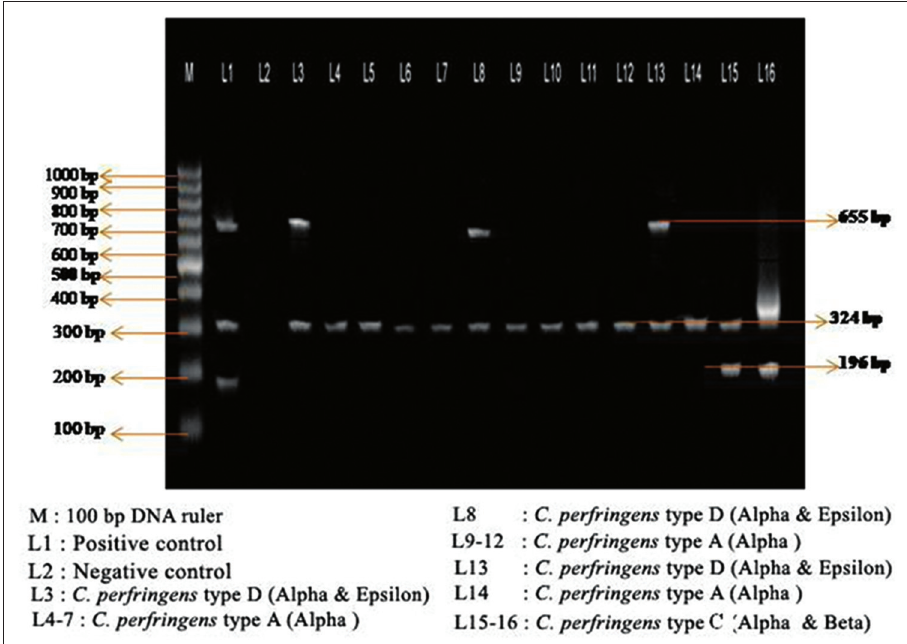
Figure-1: Agarose gel electrophoresis of amplicons of alpha, beta and epsilon toxin genes of Clostridium perfringens isolates screened by multiplex Polymerase chain reaction, M: 100 bp DNA ruler, L1: Positive control, L2: Negative control, L3: Clostridium perfringens Type D (Alpha and Epsilon), L4-7: Clostridium perfringens Type A (Alpha), L8: Clostridium perfringens Type D (Alpha and Epsilon), L9-l2: Clostridium perfringens Type A (Alpha), L13: Clostridium perfringens Type D, L14: Clostridium perfringens Type A, L15-16: Clostridium perfringens Type